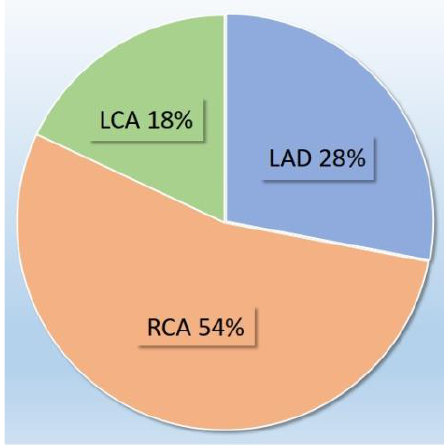
Figure 2. Coronary artery CTO distribution. Table 1. Baseline clinical features on admission.